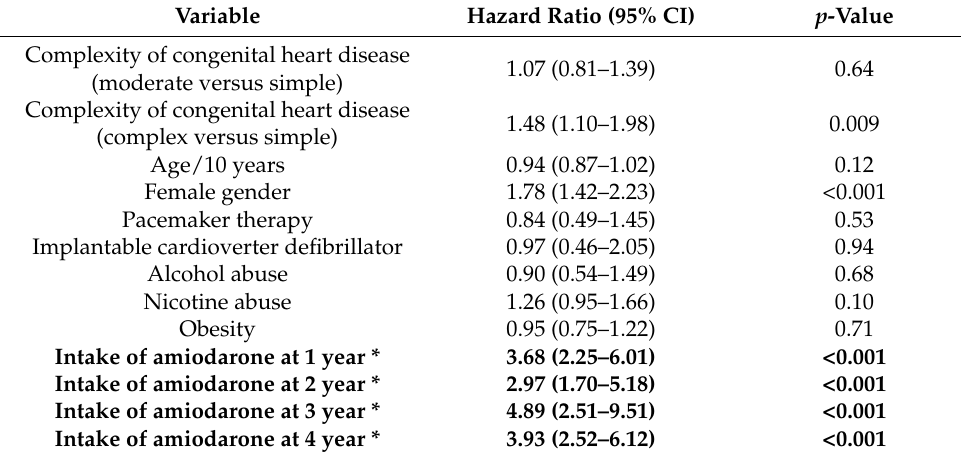
Table 3. Results of the propensity score-matched analysis after any amiodarone treatment in adults with congenital heart disease (ACHD) compared to amiodarone-naïve ACHD.